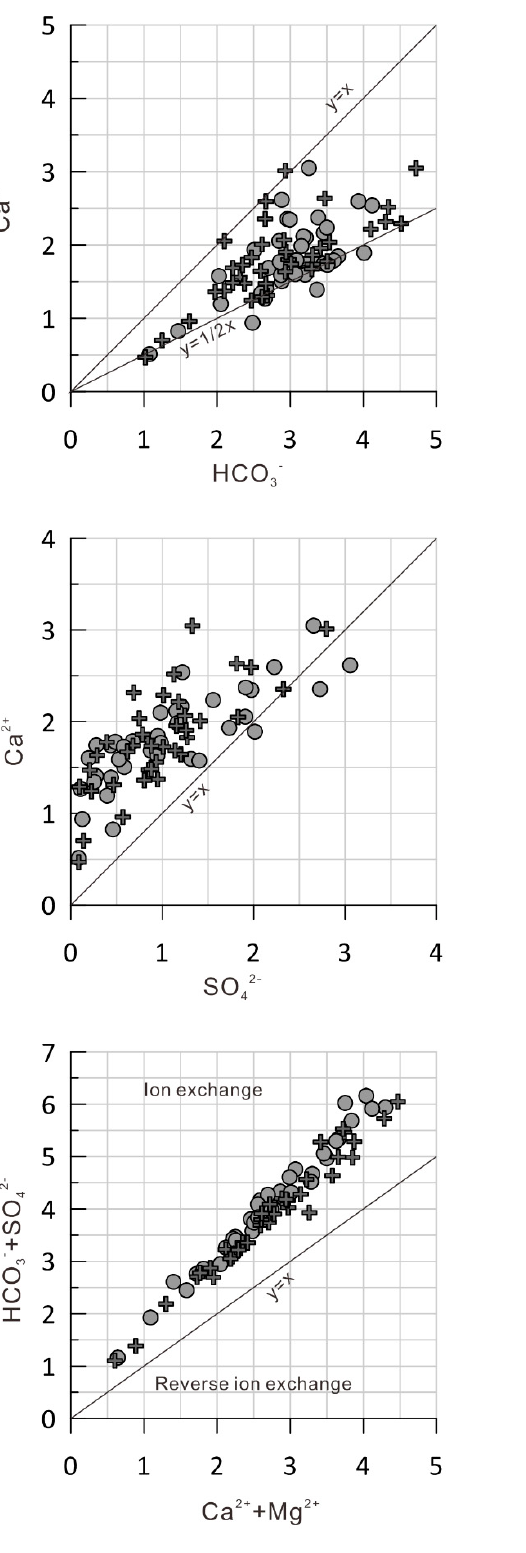
Figure 5. Diagram of the major ion relations for the water samples from the upper reaches of Syr Darya River and its tributaries. The grey dots are the water samples collected during the low-flow season (LFS) and the black crosses are those collected during the high-flow season (HFS).